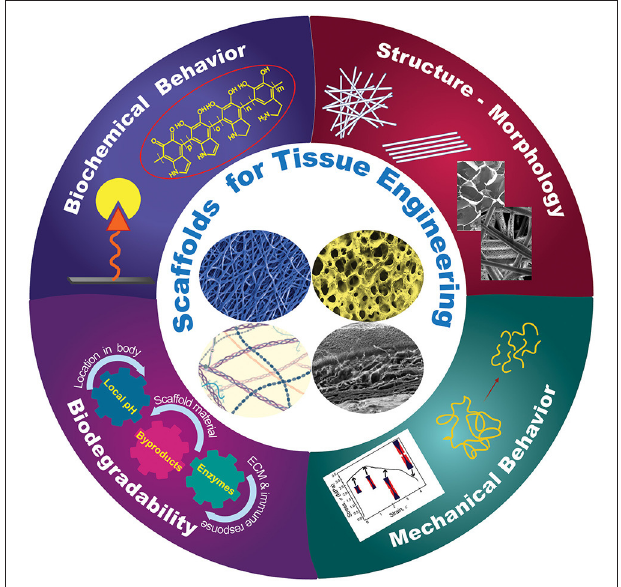
FIGURE 1 | Schematic representation of different design characteristics of biomaterial scaffolds that are necessary for eliciting the cellular behavior required for a specific tissue application. Effective tuning of the parameters described in each category plays a critical role in the performance of architectured (fibrous and porous), hybrid, and hydrogel scaffolds for tissue generation and